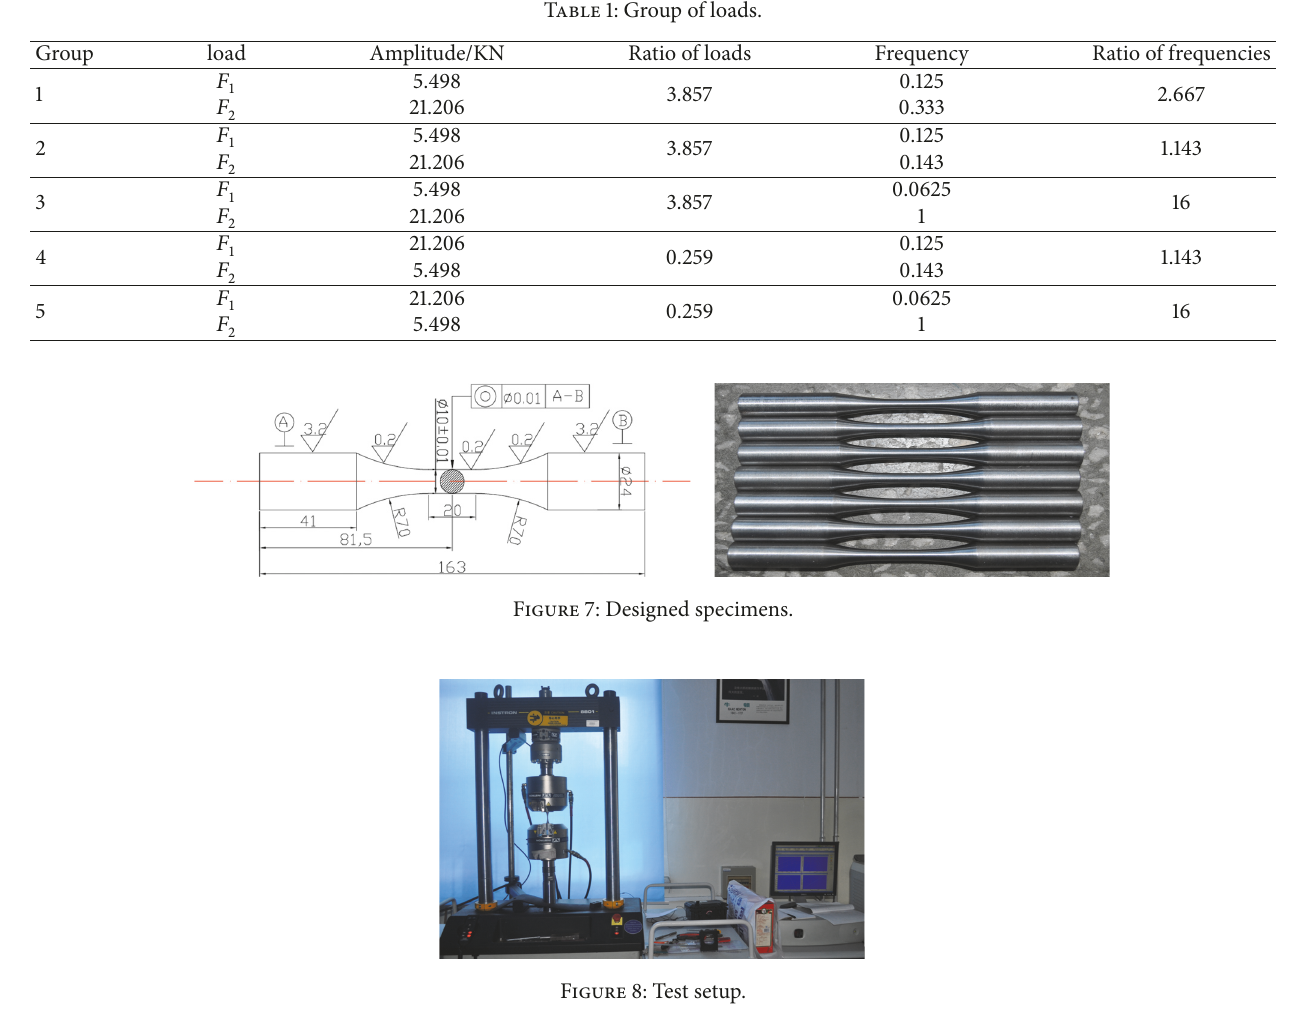
Table 1: Group of loads.